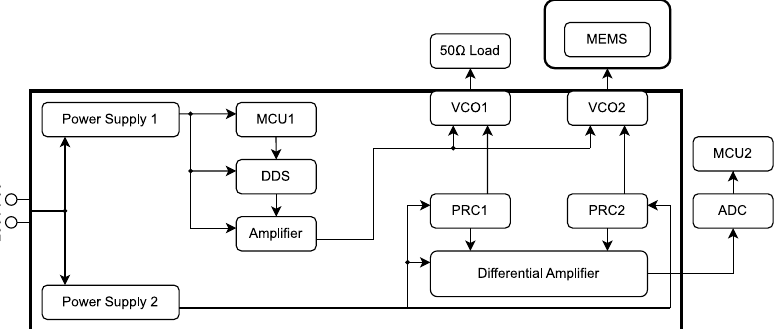
Figure 14. Block diagram of mechanical quantity (single component force) sensing